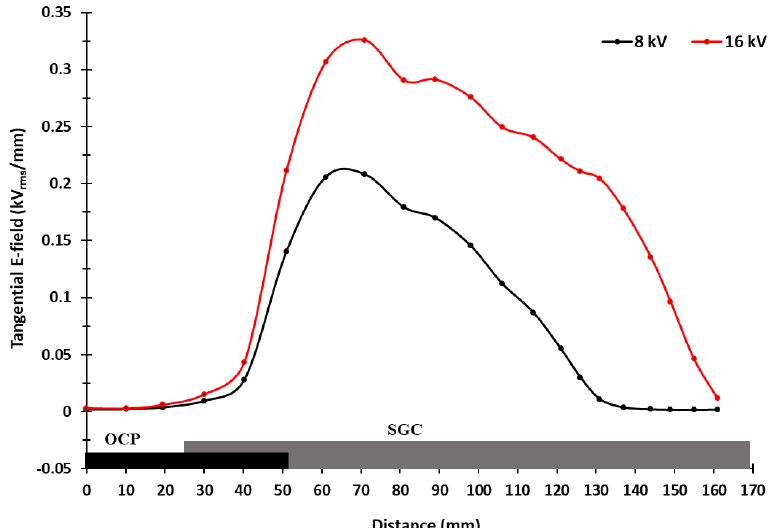
Figure 7. Distributions of the E t obtained at the surface of the stress grading system for an applied voltage of 8 kV rms and 16 kV rms .